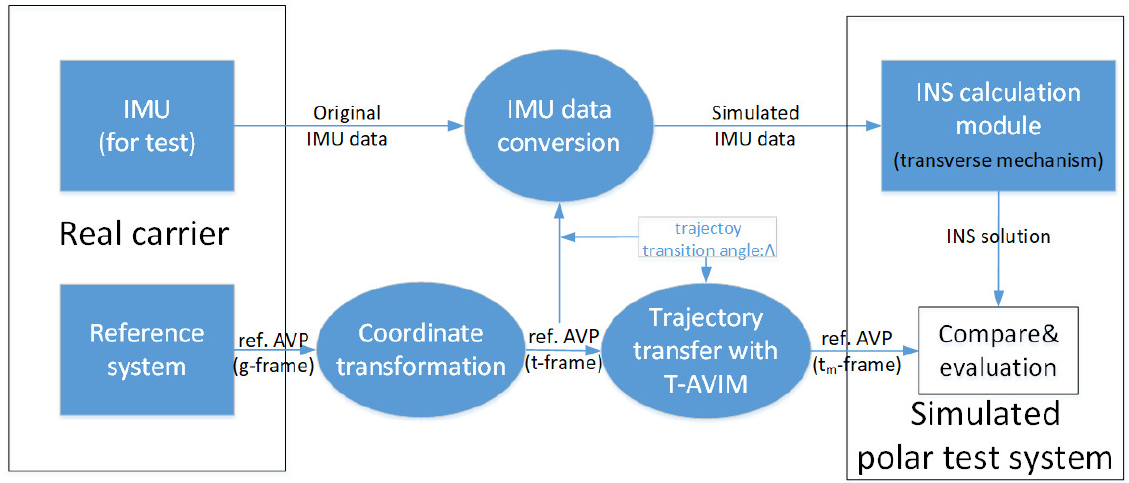
Figure 1. Flow chart of INS P-ML simulation test using T-AVIM under Earth sphere model.